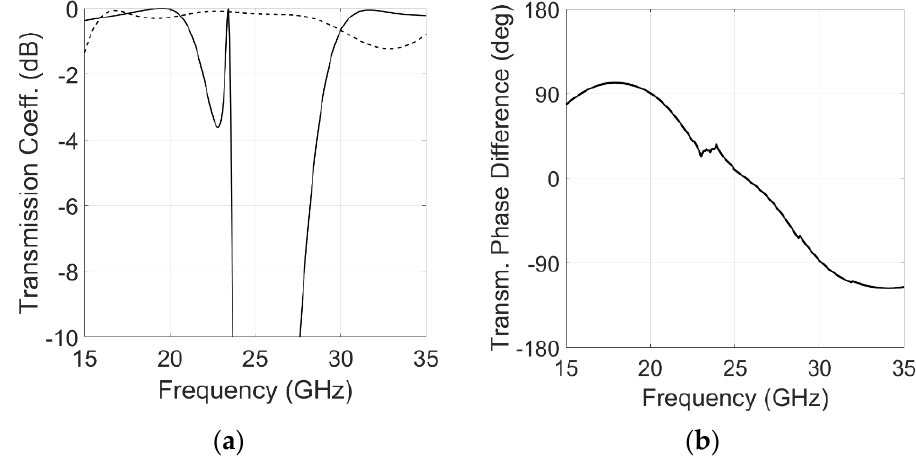
Figure 6. Simulated transmission coefficients of the equivalent circuit of the proposed converter. ( a ) Module of the transmission coefficient: Continuous line, x-polarization; dashed line, y-polarization. ( b ) Transmission coefficient phase difference.